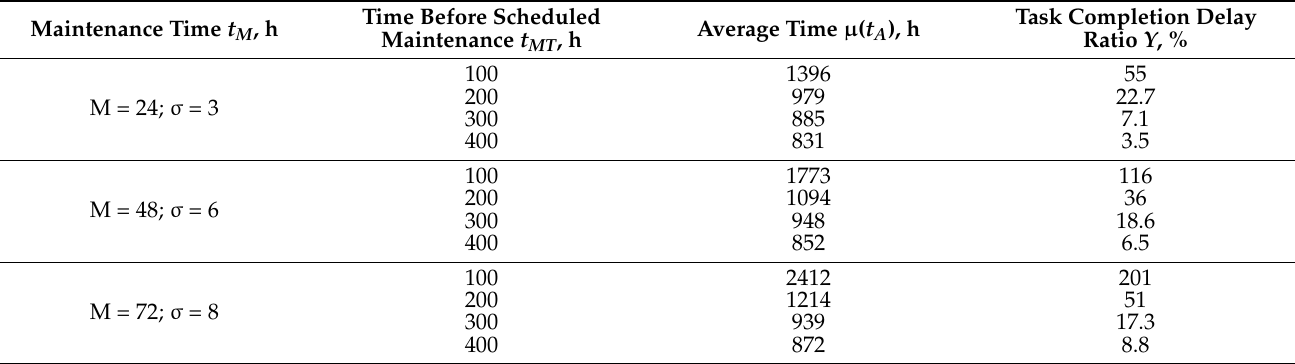
Table A4. Maintenance efficiency assessment.